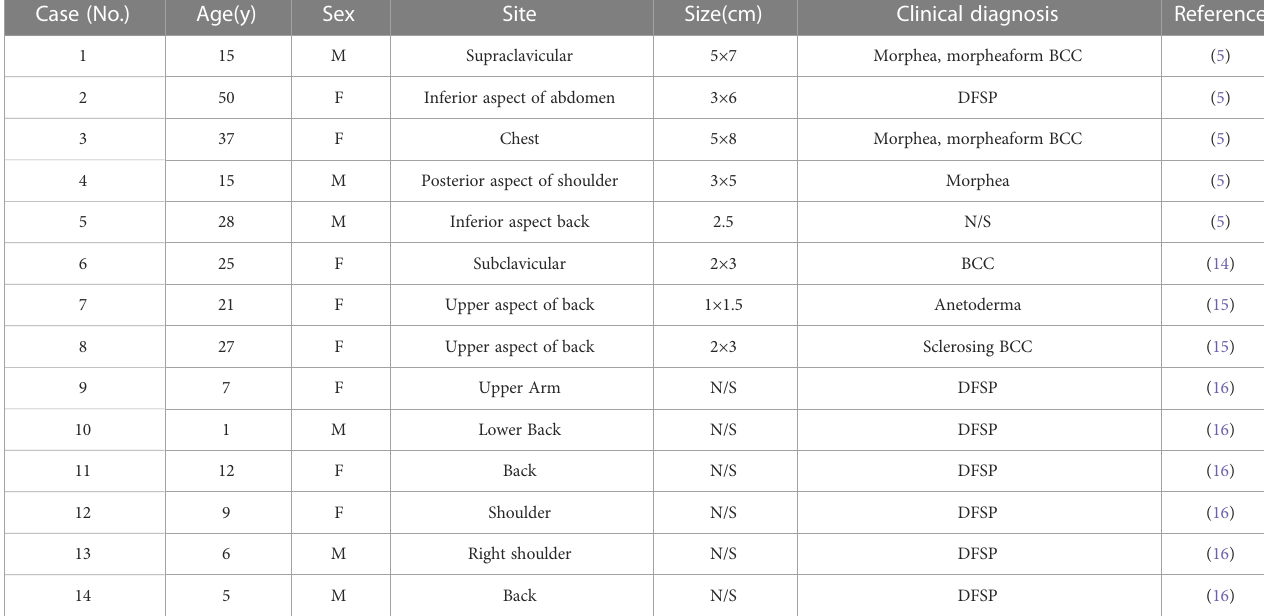
TABLE 1 Reported cases of atrophic dermato fi brosarcoma protuberans. Case